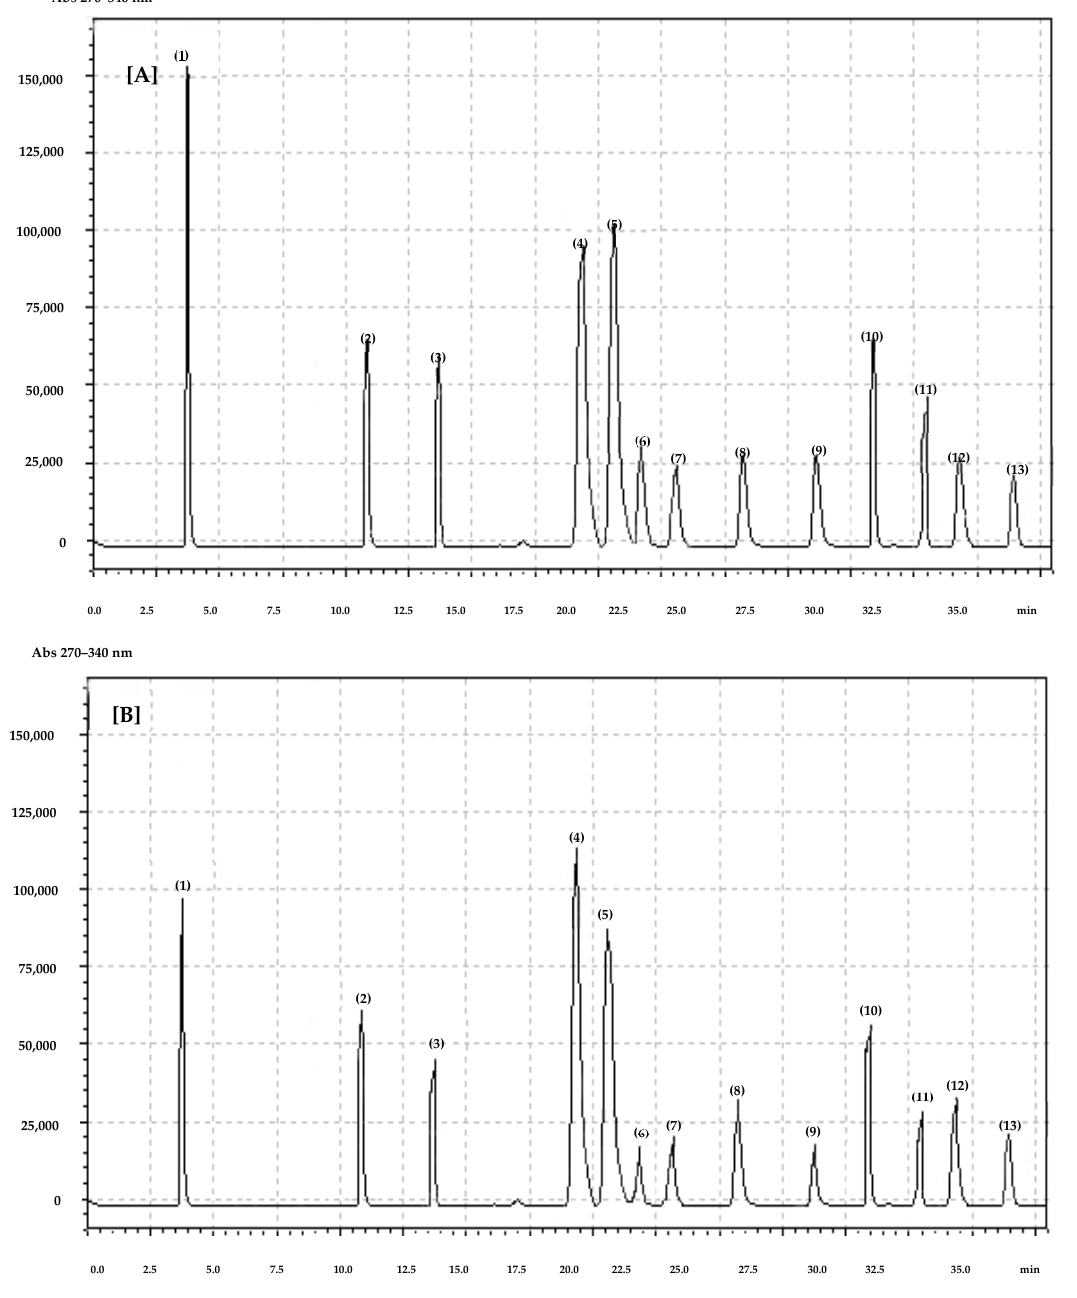
Figure 3. Chromatogram of polyphenols identified in ( A ) horse chestnut and ( B ) red horse chestnut flowers. (1) gallic acid, (2) chlorogenic acid, (3) caffeic acid, (4) quercetin-3-O-rutinoside, (5) p-coumaric, (6) ferulic acid, (7) kaempferol-3-O-glucoside, (8) myricetin, (9) luteolin, (10) quercetin, (11) quercetin-3-O-glucoside, (12) apigenin, (13) kaempferol. Table 4. Content of identified phenolic acids and flavonoids (mg/g FW) and antioxidant activity (mMol/100 g FW) in both species of horse chestnuts’ flowers and leaves (mean value ± standard error). N.S (statistically not significant) Flowers Leaves 2018 Red Horse Horse Chest- Horse Chestnut Red Horse Chestnut Chestnut nut